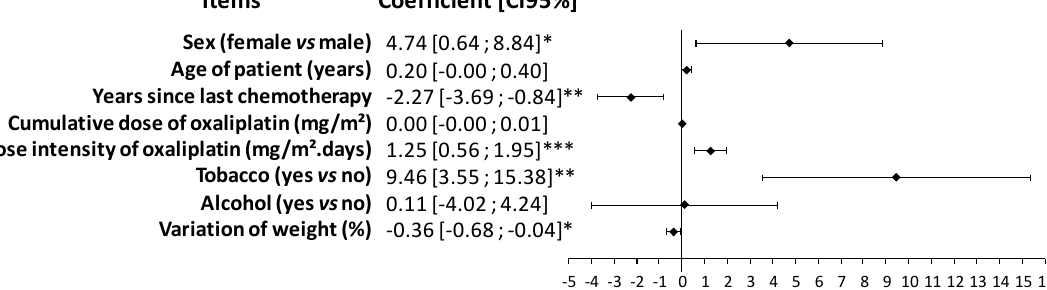
Figure 4. Forrest plot of the regression coefficients comparing QLQ-CIPN20 sensory scores with patient characteristics and oxaliplatin treatments. Multivariable analyses were performed, including patient characteristics (sex, age, tobacco, alcohol, and variation of weight) and characteristics of chemotherapy (chemotherapy date, cumulative dose and dose intensity of oxaliplatin, and center). * p < 0.05, ** p < 0.01, and *** p < 0.001.